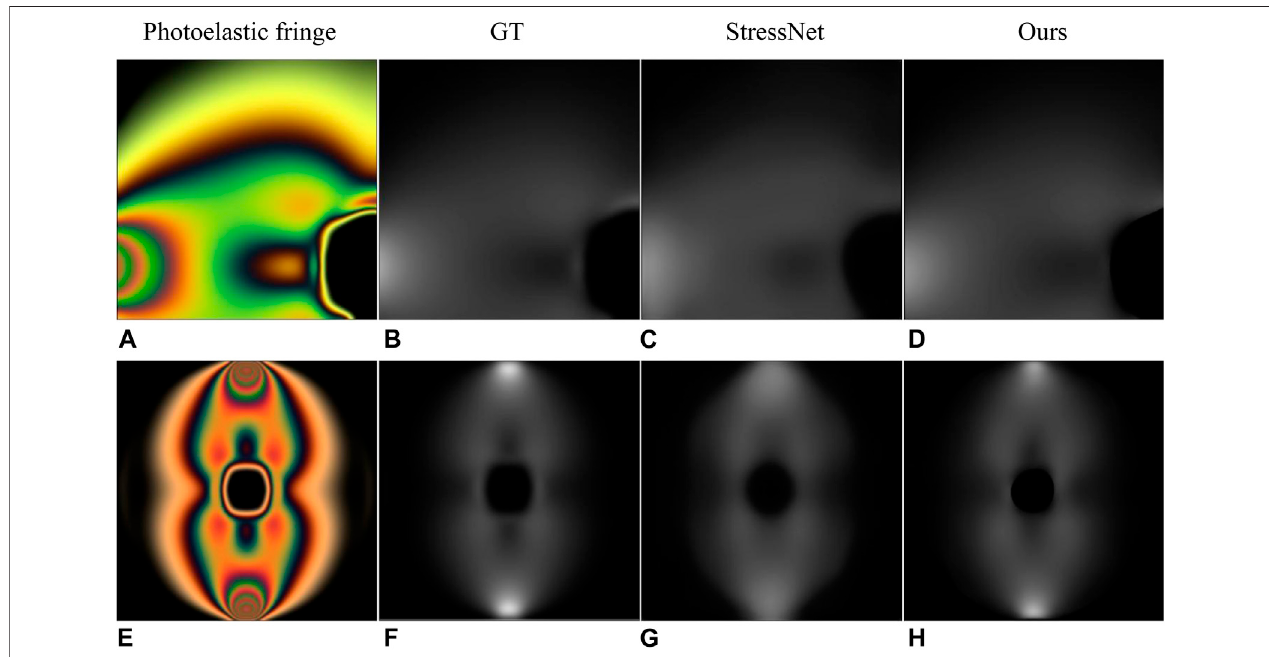
FIGURE 5 | Results of comparison with StressNet (Briñez de León et al., 2020b). (A,E) are photoelastic fringes obtained with fl uorescent and incandescent light sources, respectively. (B,F) are the corresponding ground truth. (C,G) are the results in StressNet. (D,H) are the results of our method.